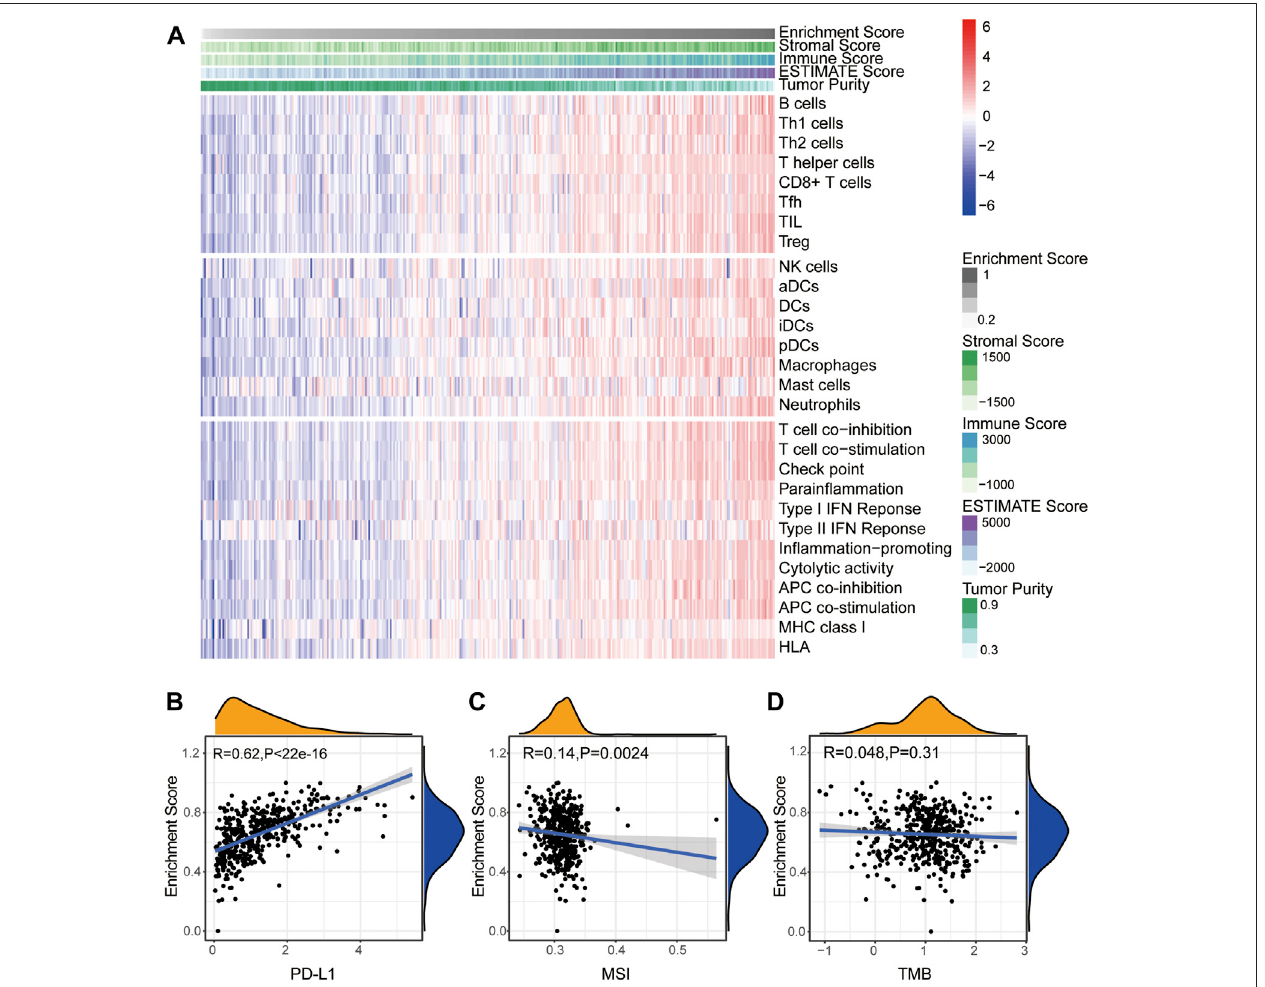
FIGURE4| Turquoise module correlates withimmuneactivationin SKCM. (A) Heatmap ofthe enrichment scoreand in fi ltrationof28 types ofimmune cells aswell as immune scores. (B – D) Correlation between the enrichment score of the module – gene and PD-L1 mRNA expression (B) , MSI (C) , and TMB (D) . The coef fi cient was calculated by the Spearman